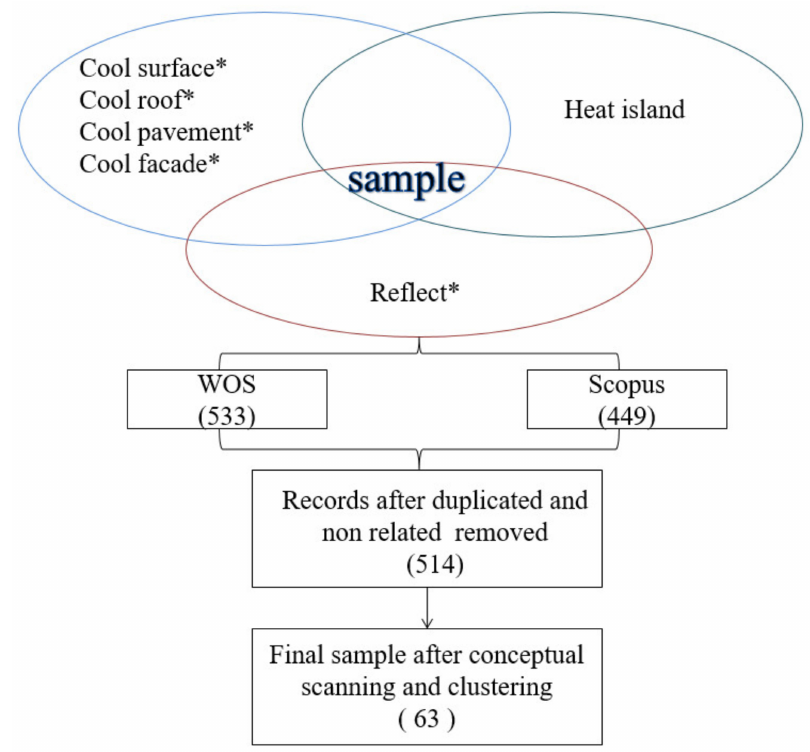
Figure 2. Data collection